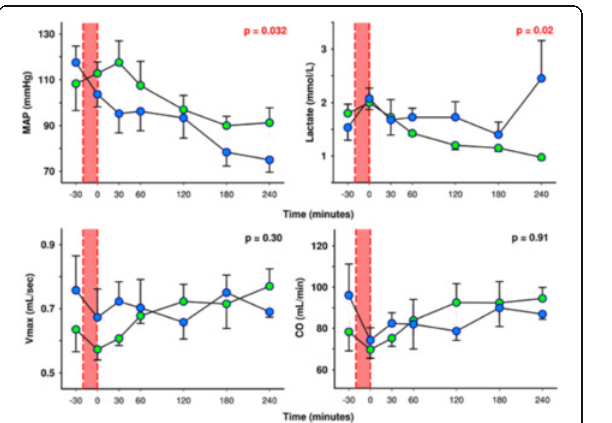
Results Time of ECG done was not significantly different between the groups, 9.8±3.3 and 7.8±2.3 minutesThe D2B time was 119.3±